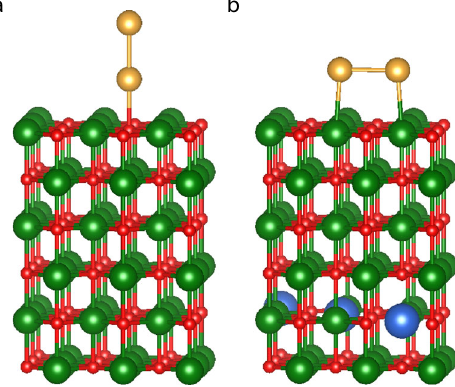
Fig. 8 Geometry of Au 2 clusters on undoped and doped MgO(001) surface. Au 2 cluster in the non-wetting geometry on the undoped a and the wetting geometry on Al-doped b MgO(001) surface represented by a periodic (3 × 3) supercell. Au atoms are shown in yellow, O in red, Mg in green and Al in blue. The con fi guration of the gold cluster has been optimized by DFT for a fi xed substrate. The structure visualization for periodic systems was carried out using VESTA 67